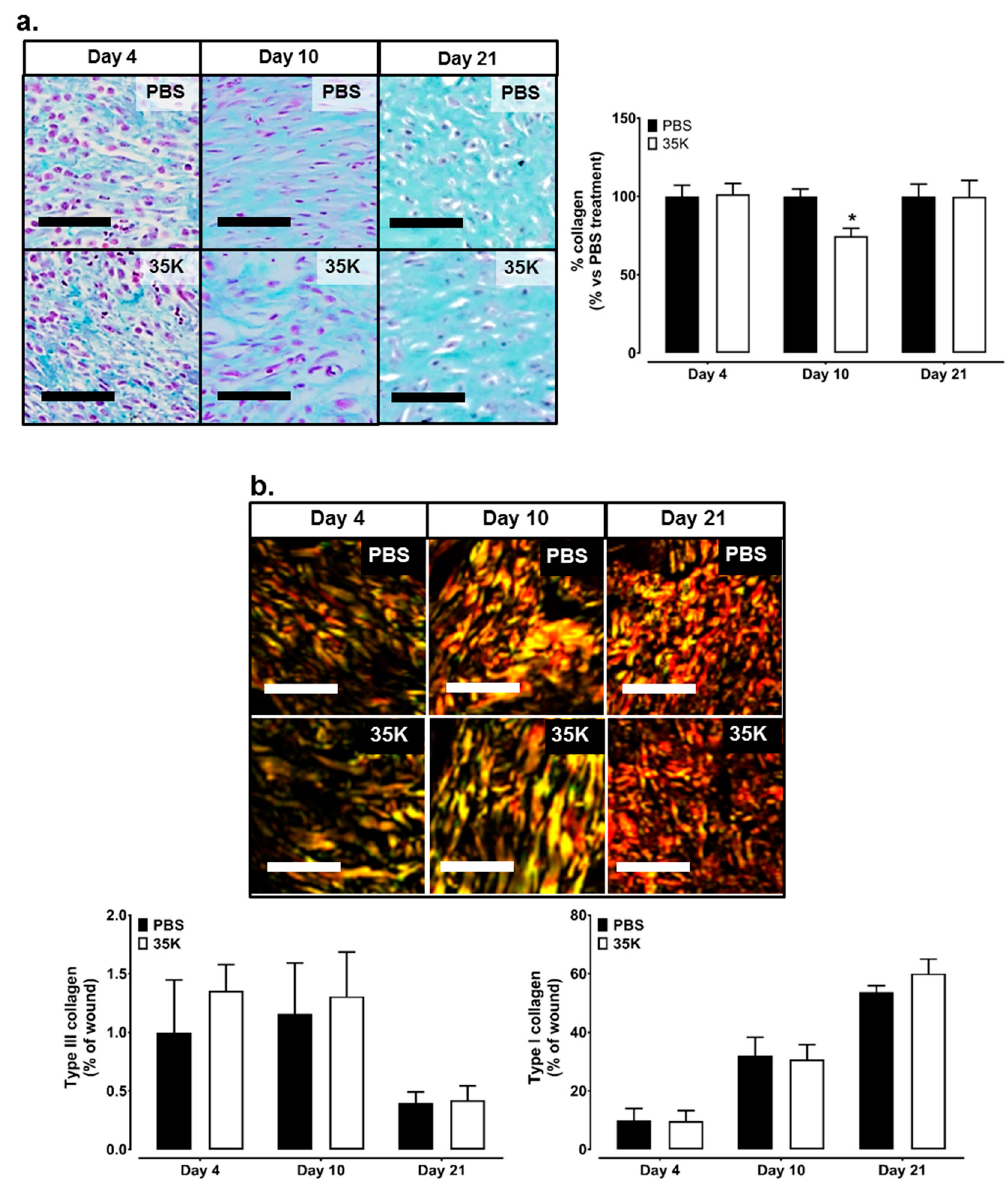
Figure 5. Inhibition of CC-chemokines by 35K decreases collagen formation in Day 10 wounds. Masson’s trichrome staining was used to detect the collagen content in the wounds. ( a ) green staining in wound sections is collagen, purple staining are nuclei; ( b ) to differentiate collagen type, wound sections were stained red with picrosirius and imaged under polarized light. Green represents Type III collagen, yellow to red represents Type I collagen. Three tiled images were taken per wound ( n = 12 or 7/treatment). Scale bars represent 50 μ m. Data is represented as mean ± SEM. Statistical analysis was performed by an unpaired two-tailed t -test. * p < 0.05 compared to PBS treated wounds.